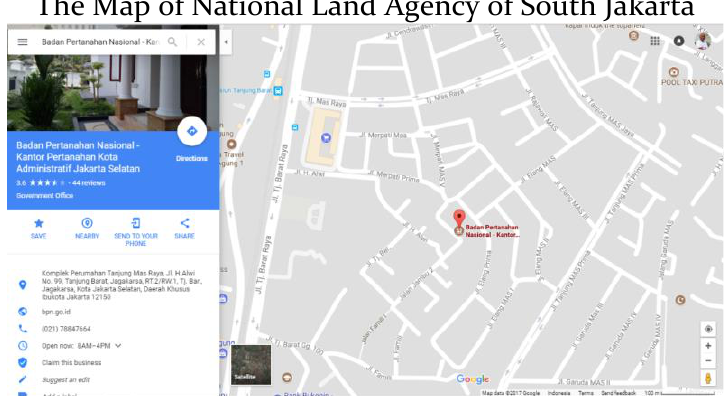
The Map of National Land Agency of South Jakarta